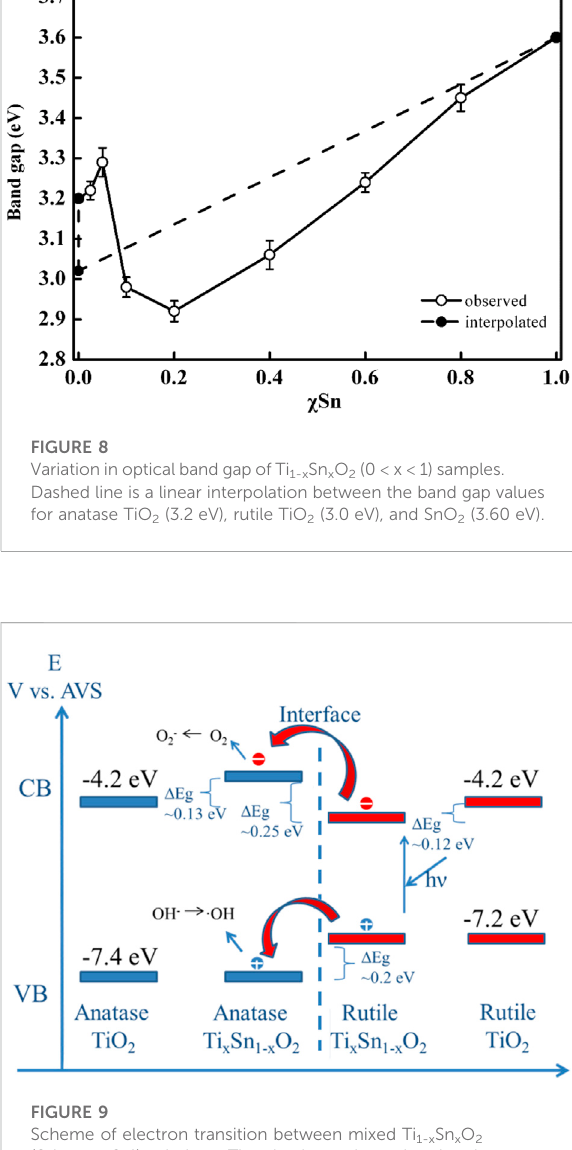
FIGURE 9 Scheme of electron transition between mixed Ti 1-x Sn x O 2 (0.1 ≤ x ≤ 0.4) solutions. The absolute valence band and conduction band edges relative to vacuum level of TiO 2 are obtained from the reference.